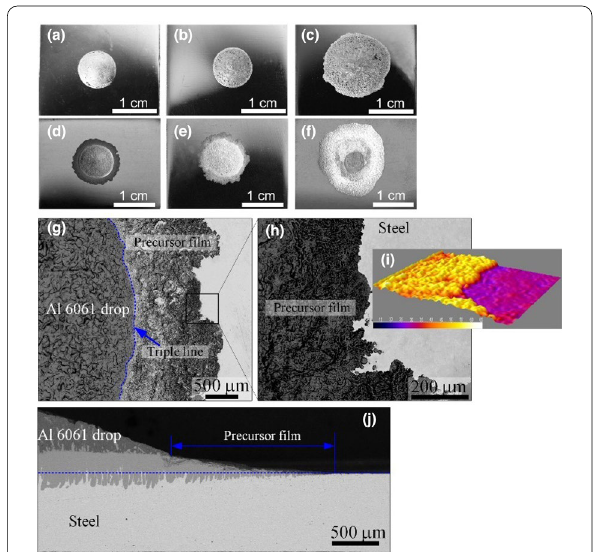
Figure 3 Appearance of representative sessile drop samples after wetting experiments in vacuum: ( a )–( c ) Al 4043 sample at 650, 700, and 750 °C; ( d )–( f ) Al 6061 sample at 600, 650, and 700 °C; ( g ) Top view at close of triple line for Al 6061 sample at 650 °C and ( h ) details for edge of PF; ( i ) Three-dimensional reconstruction of PF; ( j ) Cross-sectional view of position at close of triple line for Al 6061 sample at 600 °C